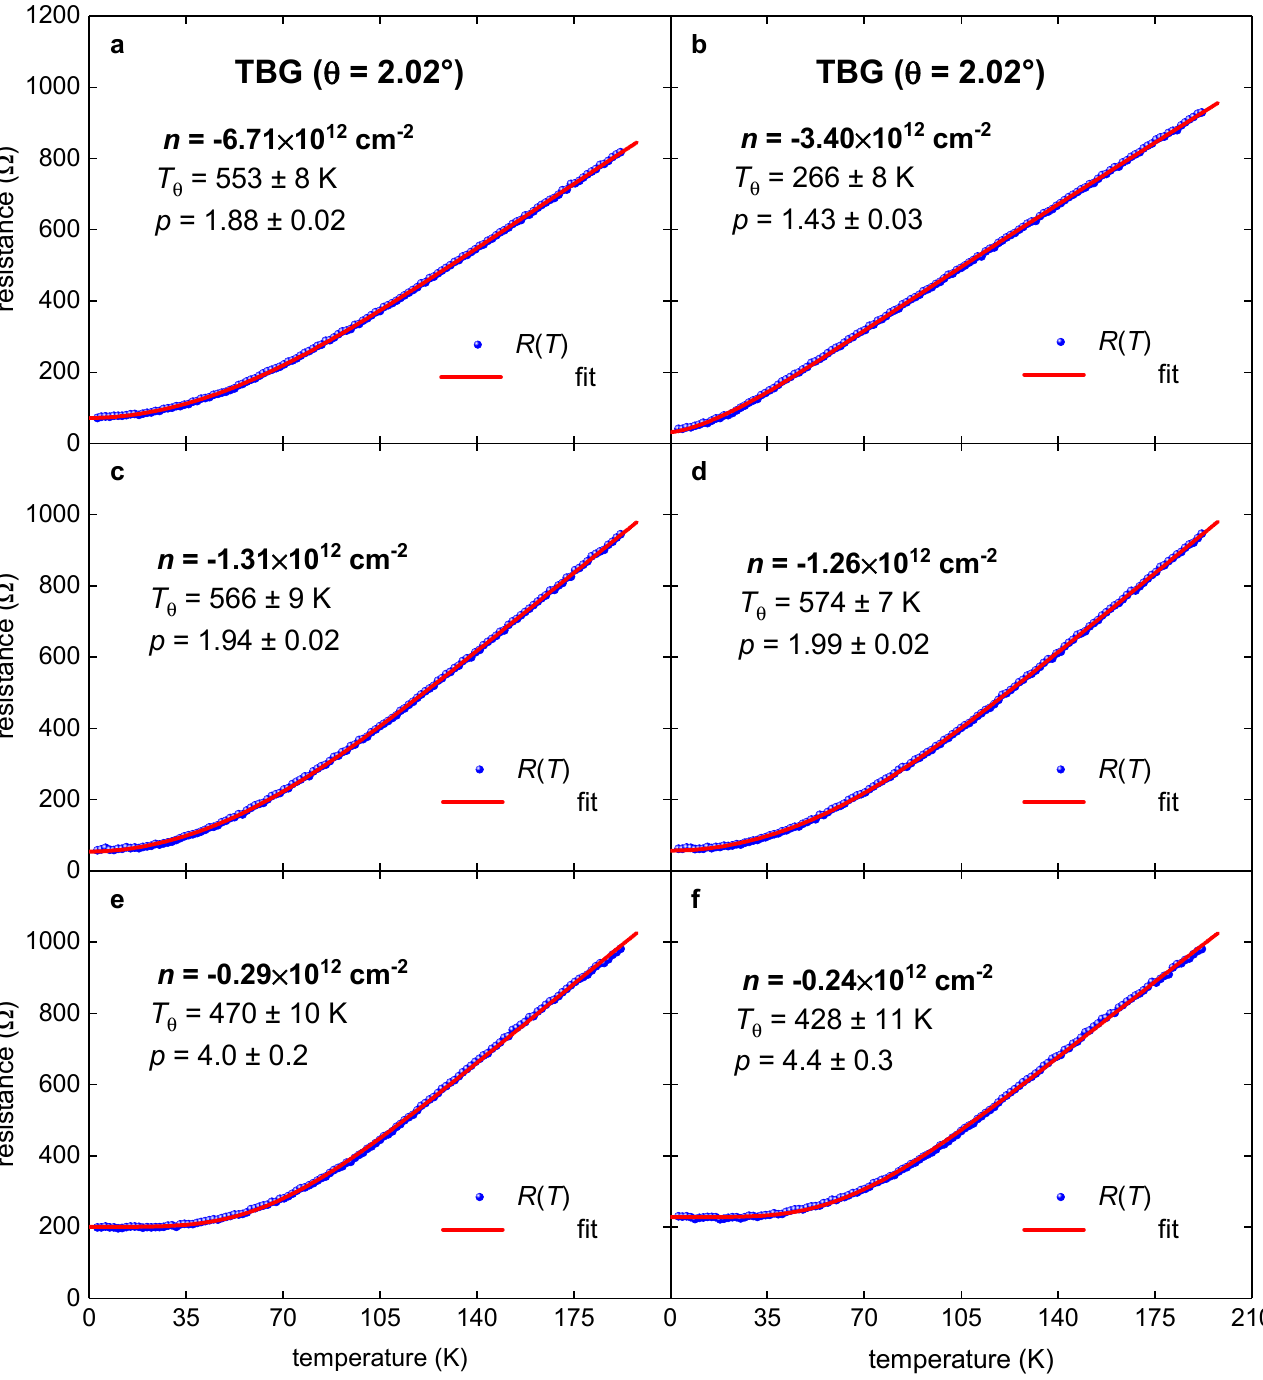
Figure 5. R ( T ) data and data fit to Equation (7) for metallic TBG superlattice on hole side with θ = 2.02° (raw R ( T ) data were reported by Polshyn et al. [8]). The doping state, n , for this TBG superlattice gradually varies from n = − 6.71 · 10 12 cm − 2 ( a ) to n = − 0.24 · 10 12 cm − 2 ( f ). Red are the fitting curves; 95% confidence bands are shown by a pink shaded area. Goodness of fit for both plots is better than R = 0.9990.